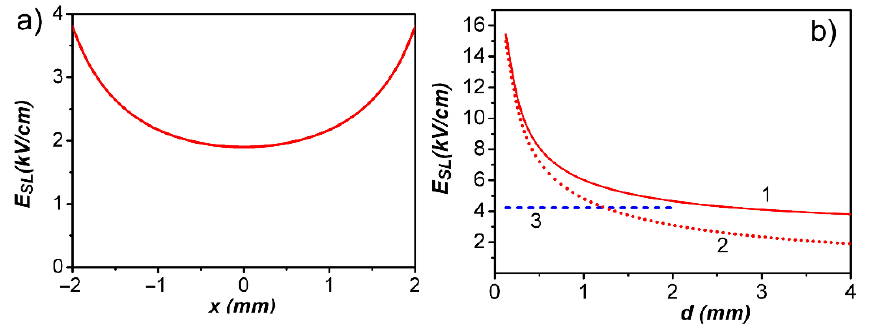
Figure 3. ( a ) Dependence of the maximum values of the electric field on the coordinate across the slot, calculated using the PWL model, d = 4 mm. ( b ) The electric field strength in the slot on its middle line (red color dotted line (2)) and on its horizontal boundaries (red color solid line (1)) depending on the slot width (PWL model). The slot width varies from 125 μm to 4 mm. The dashed blue line (3) shows the electric field strength in the slot calculated using the PPC model. The calculations were performed for an electromagnetic field in a waveguide with a power of 1 kW (the electric field amplitude on the waveguide axis is 200